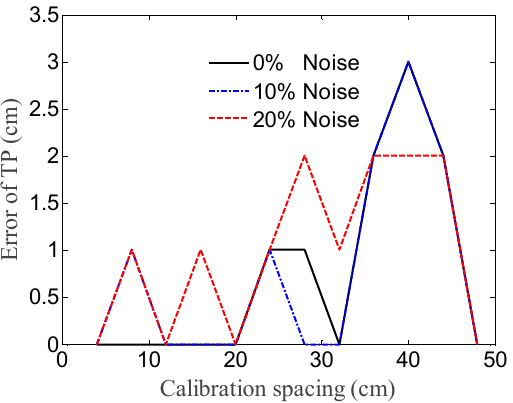
Figure 9. Identification error of the TP under different calibration spacing d.